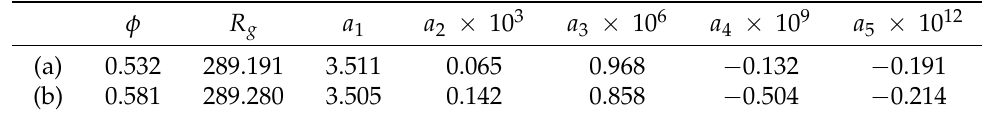
Table A1. Fuel–air equivalence ratio φ , mass-basis gas constant R g and specific heat capacity coeffi- cients a i for exhaust gases at test points (a) and (b). The unit of R g and c p is: [J · kg − 1 · K − 1